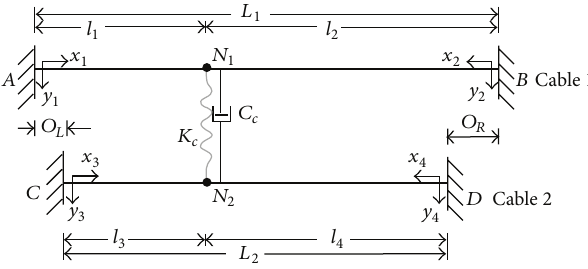
Figure 1: Schematic layout of a two-cable network with damped flexible